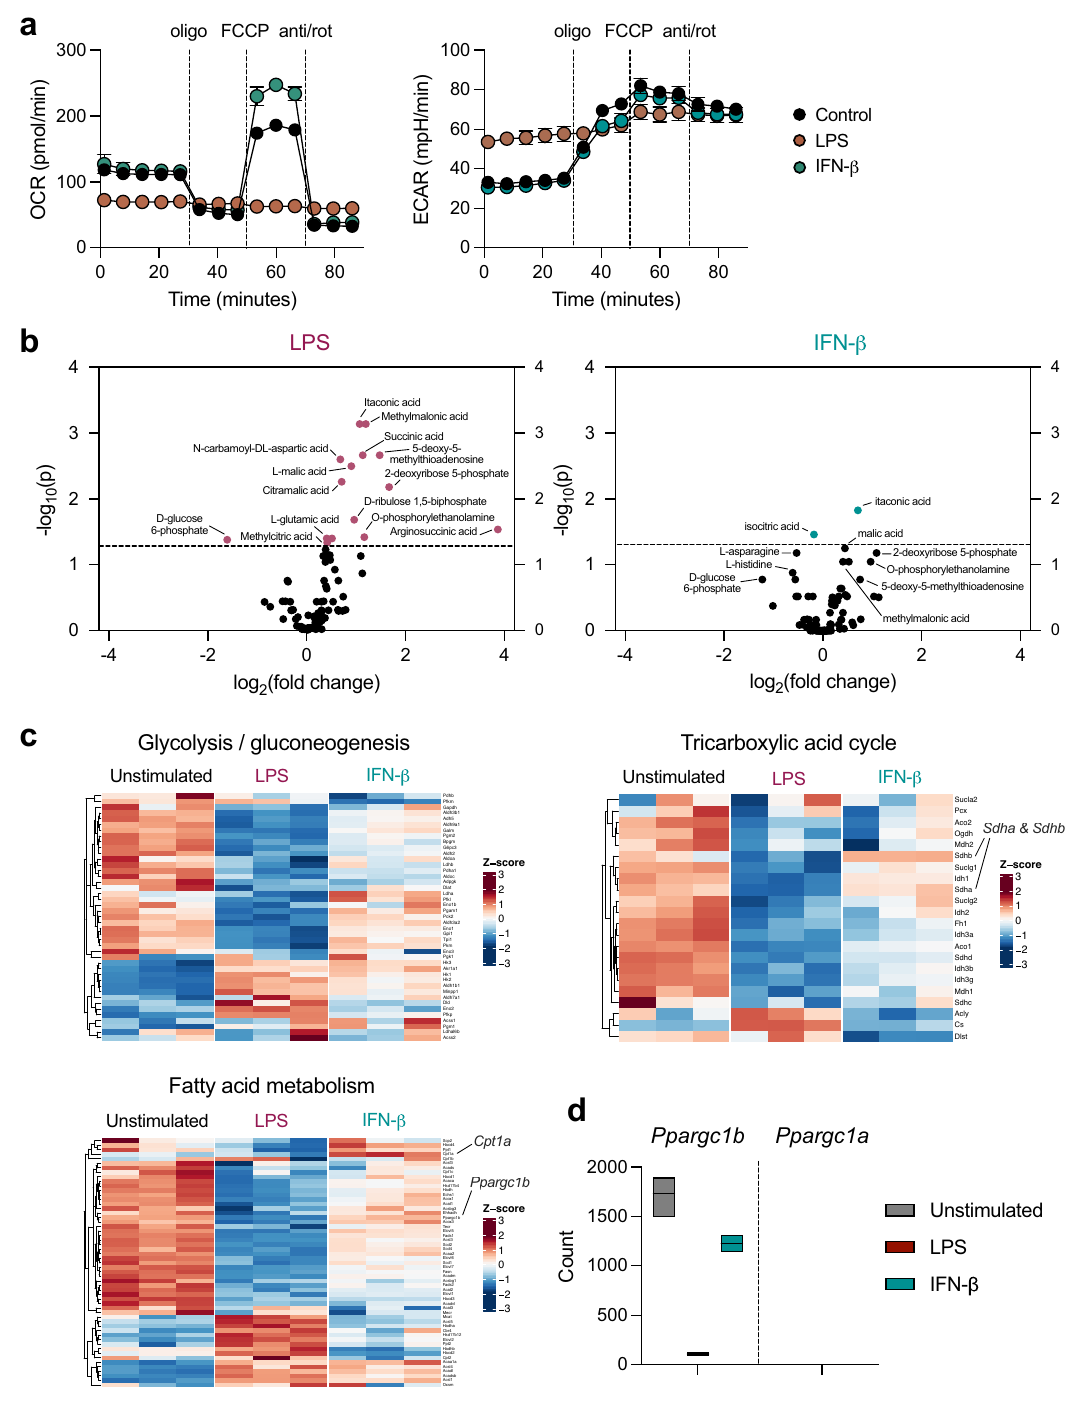
Figure 1. Comparing metabolite and gene expression profiles of metabolically distinct DCs. DCs were stimulated with LPS (100 ng/mL) or IFN-β (1000 U/mL) for 18 h and the ( a ) OCR (left) and ECAR (right) were measured by Seahorse bioanalyzer over time with sequential treatments with oligomycin (oligo), FCCP, and antimycin and rotenone (anti/rot). ( b ) Volcano plot of data significance (-log 10 (p)), with a dotted line at p = 0.05, versus log 2 (fold change) for changes in metabolite relative abundance in LPS-activated DCs (left) and IFN-β- treated (right) compared to unstimulated DCs. ( c ) Heat maps of expression of genes related to KEGG pathways of glycolysis/gluconeogenesis, tricarboxylic acid cycle, and fatty acid metabolism, by unstimulated DCs, or DCs activated with LPS or IFN-β for 6 h. ( d ) Raw counts from RNA sequencing data of Ppargc1b and Ppargc1a. Data in ( a ) are of one experiment representative of at least three experiments (mean and s.d. of five